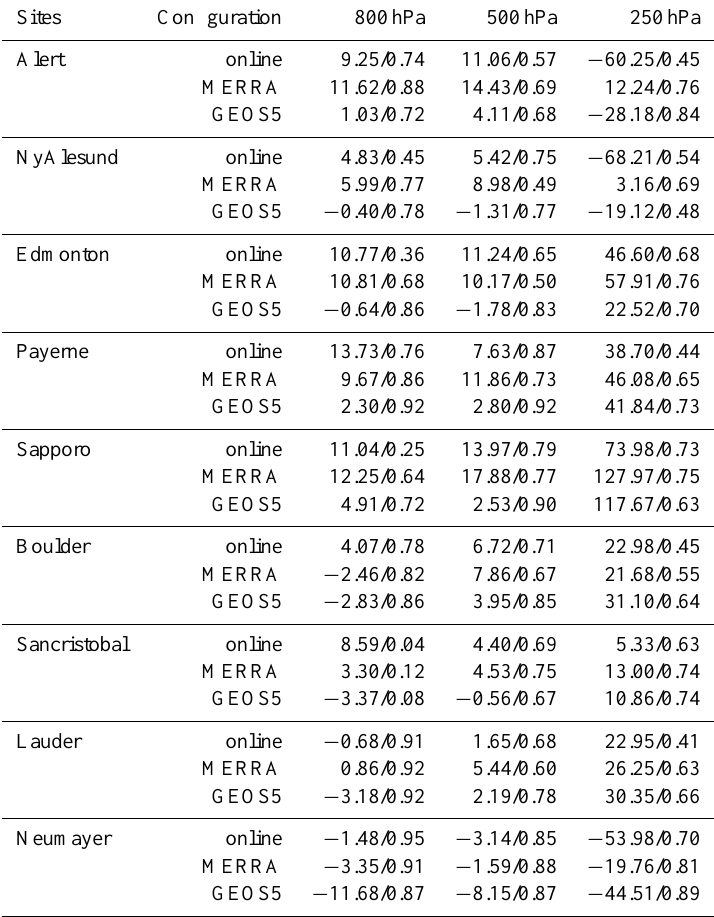
Table 8. Bias (ppb) and correlation coefficient ( r ) of ozone timelines between ozone sonde observations and model results for a matching time